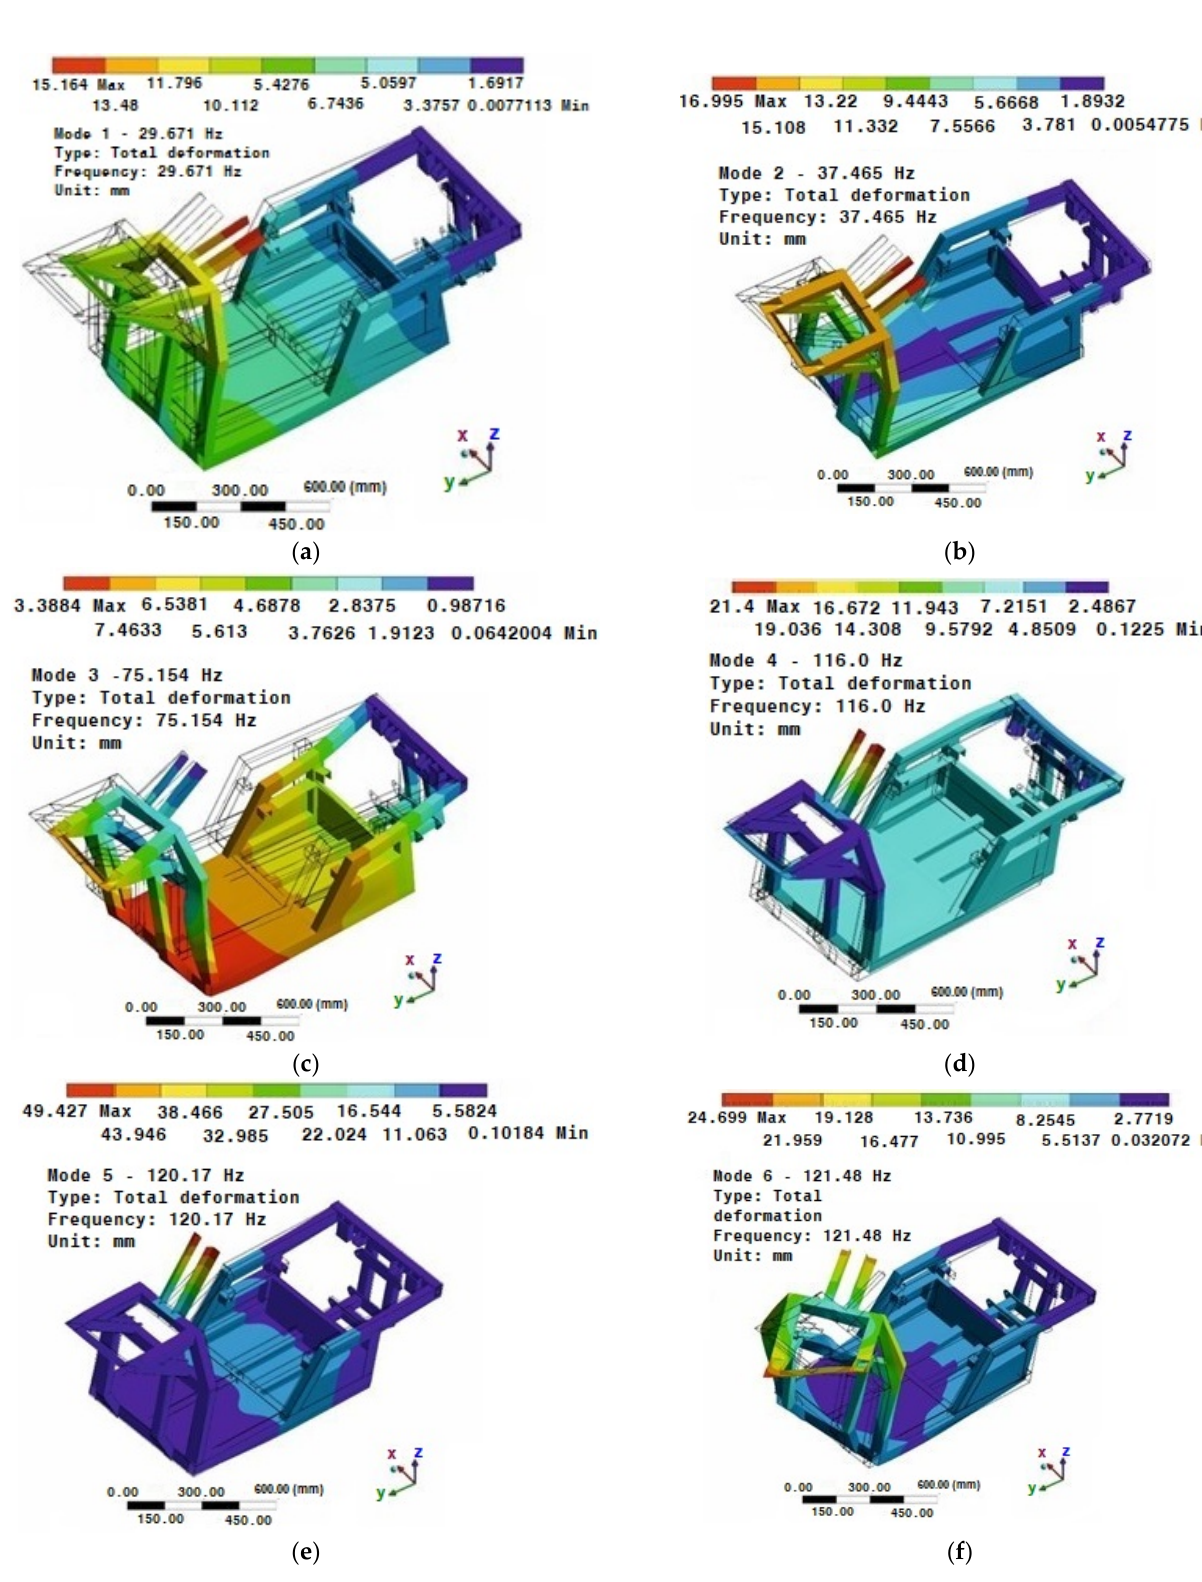
Figure 17. Eigenmodes of the vehicle frame of the E3-cycle: ( a ) first mode; ( b ) second mode; ( c ) third mode; ( d ) fourth mode; ( e ) fifth mode; ( f ) sixth mode.